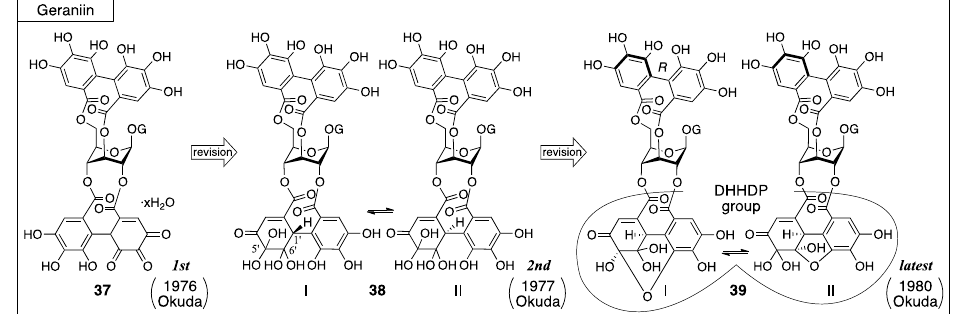
Figure 19. The transition of the structure of geraniin.